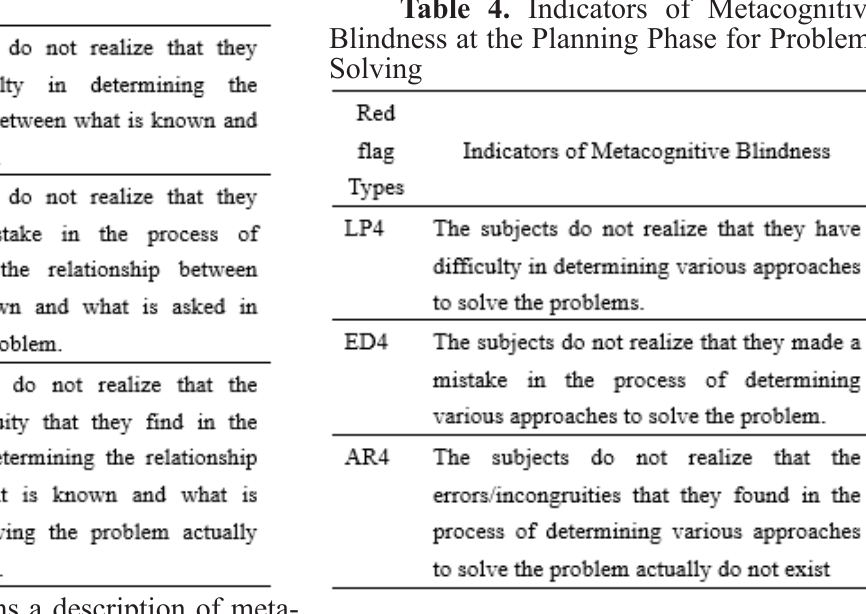
Table 4. Indicators of Metacognitive